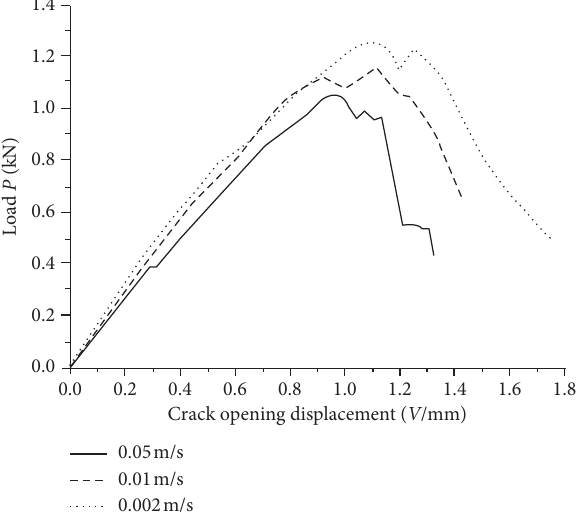
Figure 10: P - V curve of the three-point bending test under different loading